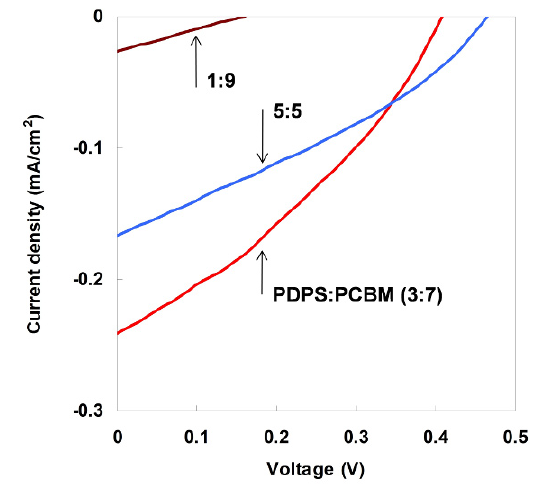
Measured J-V characteristics of the PDPS:PCBM struc- ture under illumination is shown in Figure 4. Photocur- rents were observed under illumination, and each structure showed characteristic curves with short-circuit current and open-circuit voltage.